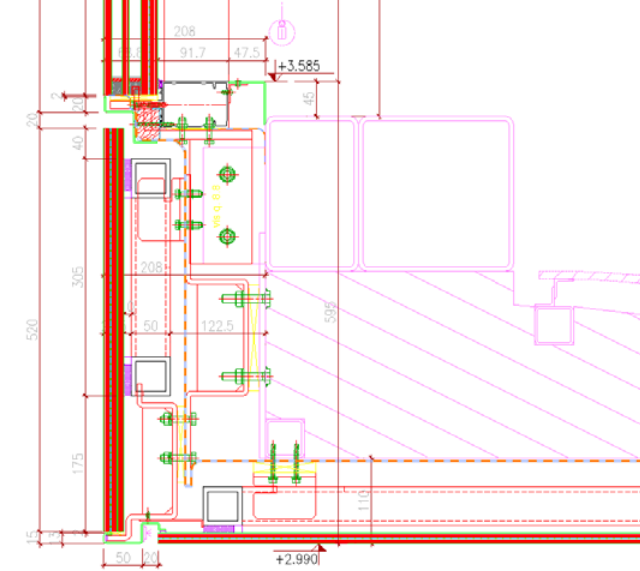
Fig. 7: Vertical section showing ceiling, glass fiber beam, cladding and connection to fixed